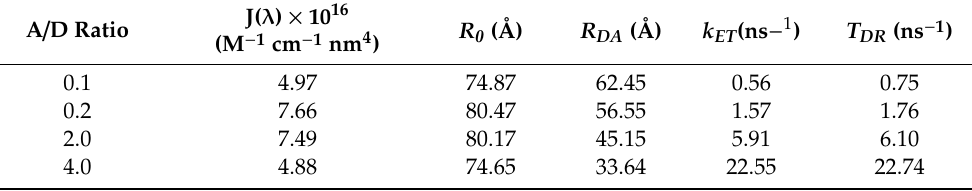
Figure 9. Energy transfer efficiency vis R DA /R 0 for 0-D Cs 4 PbBr 6 /MEH-PPV hybrid thin films. The energy transfer distance between D and A molecules ( R DA ) was based on R 0 , I D , and I DA . Figure 10 displays that as the A/D ratio increased from 0.1 to 4, the R DA decreased from 62.45 to 33.64 Å (Table 2).